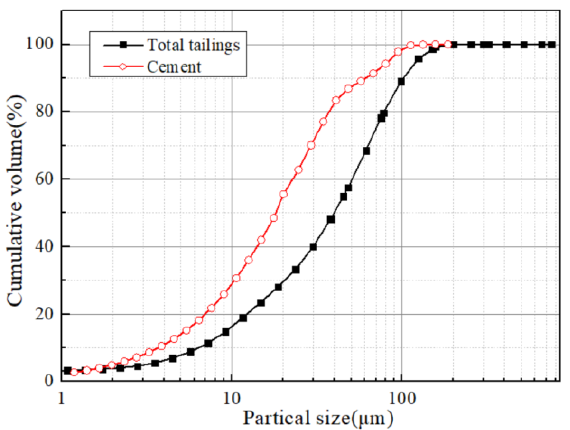
Figure 1. The curves of the cement and tailings between cumulative volume and particle